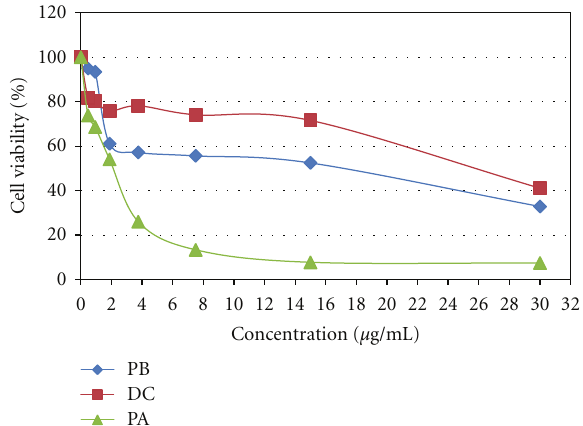
Figure 3: Percentage viability of HL60 cells treated with di ff erent concentration of pyranocycloartobiloxanthone A (1) (PA), dihy- droartoindonesianin C (2) (DC), and pyranocycloartobiloxanthone B (3) (PB) measured after 72 hours using MTT assay.